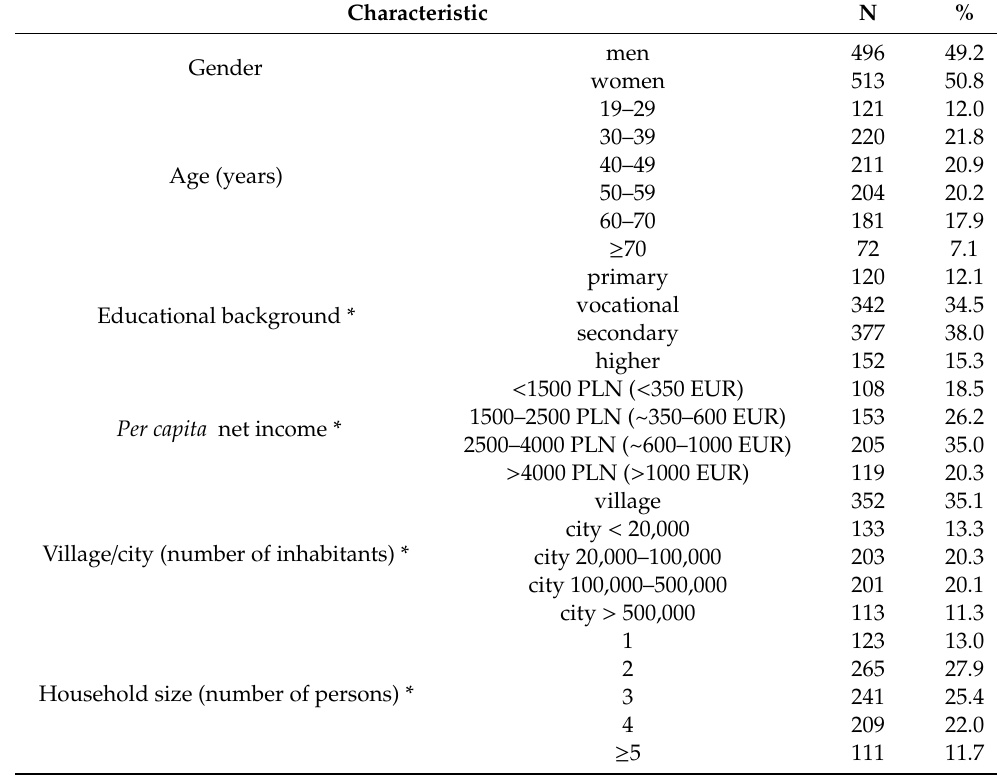
Table 1. The characteristics of the included participants of the study ( n =